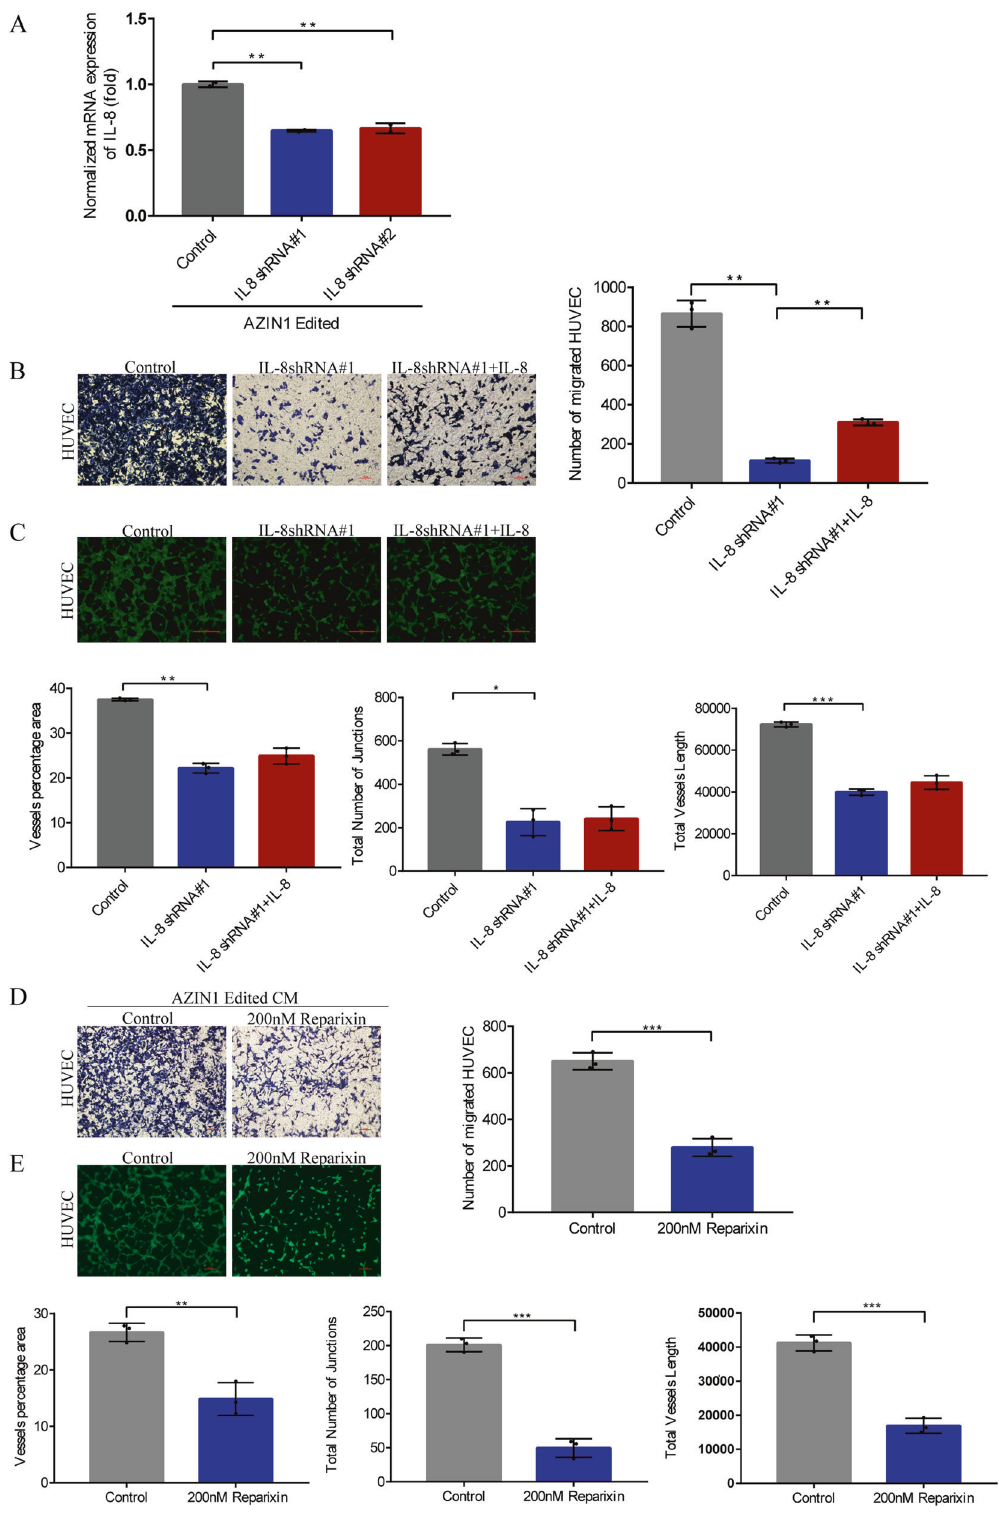
Fig. 5 Knock-down of IL-8 decreased migration and tube formation of HUVEC. A RT-qPCR tested IL-8 mRNA level in IL-8 knock-down groups from HCT116 AZIN1 edited. B Migration of HUVEC. Scale bars, 100 μ m. C Tube formation of HUVEC by treatment of CM from HCT 116 edited AZIN1 which IL-8 was knocked down by shRNA#1 or not. Scale bars, 500 μ m. D Migration and E tube formation of HUVEC by treatment of reparixin. Scale bars, 100 μ m. Data are presented as means ± SD. n = 3. One-way ANOVA with Tukey ’ s test as post-hoc test was used to assess the difference of data in A – C . Data in D and E were analyzed with unpaired Student ’ s t test. * P < 0.05, ** P < 0.01, *** P < 0.001.